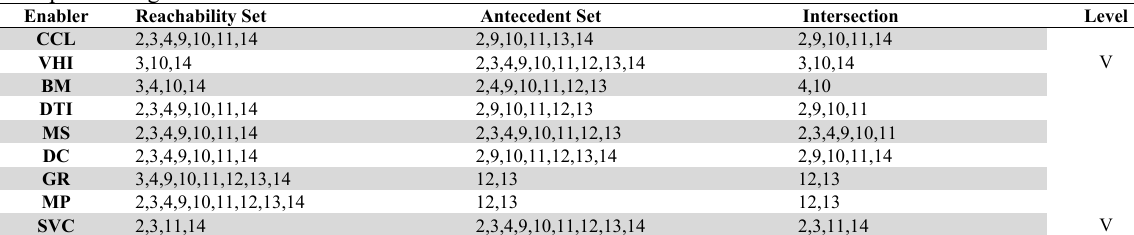
Level partitioning Iteration 5